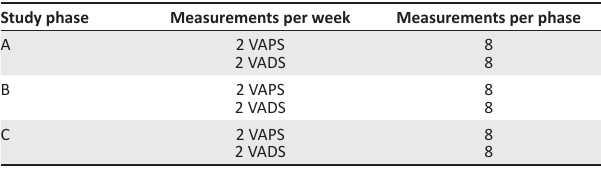
TABLE 2: Measurement time